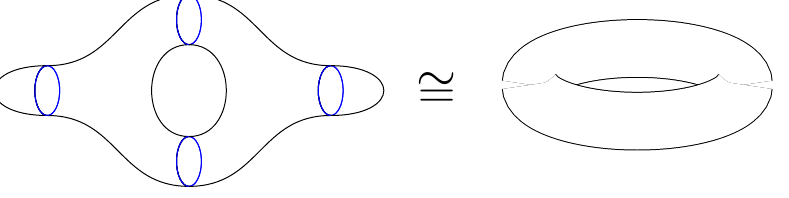
Figure 2 . Obtaining a torus from elementary pieces. On the left, the gluing is an integration over boundary conditions (in